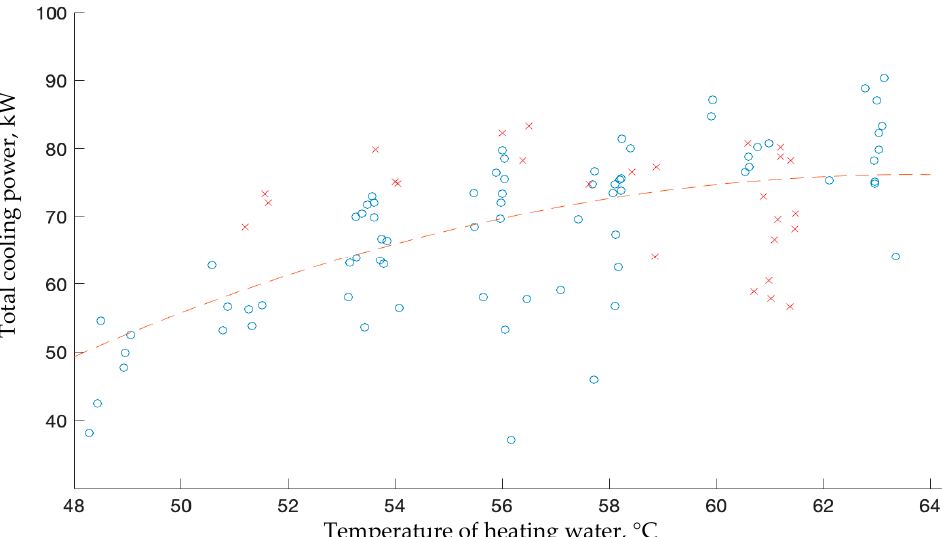
Figure 11. The total cooling power of the chiller with respect to the temperature of the heating water with cooling water temperature 25 °C and a switching time of 800–1000 s. Blue circles—original control system, red crosses—new control system.